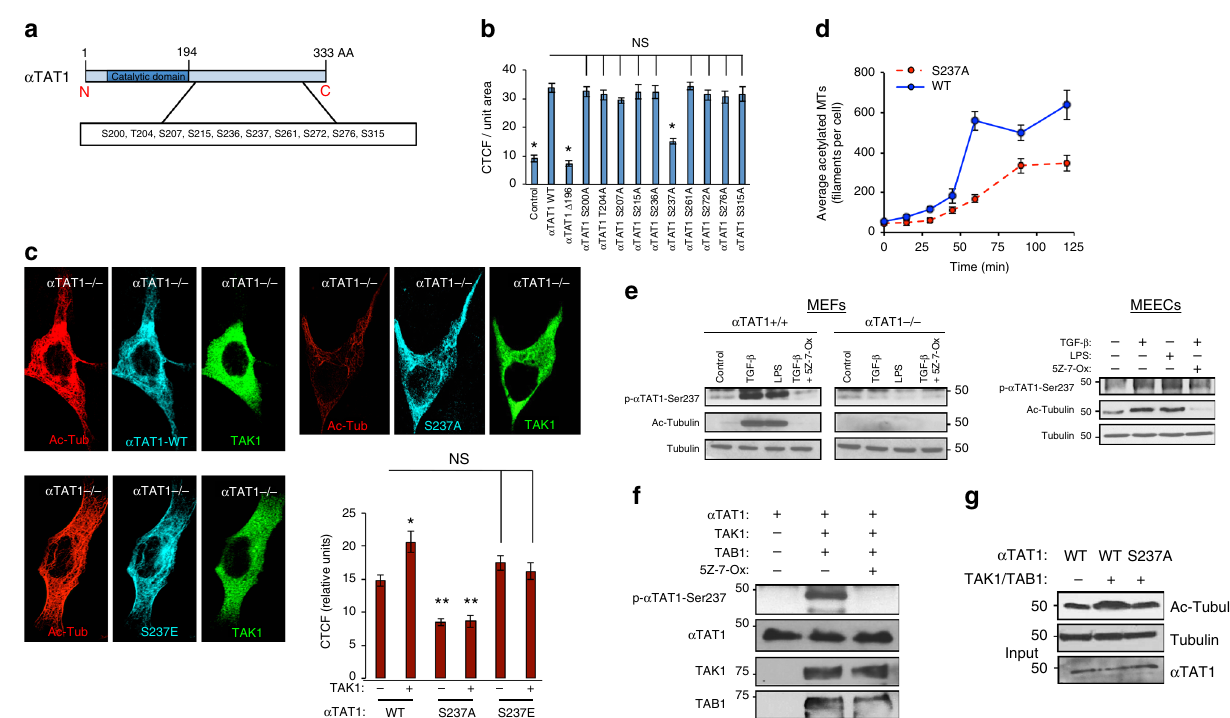
Fig. 4 α TAT1 catalytic activation requires direct phosphorylation at Ser237 by TAK1. a Schematic representation of α TAT1 serine/threonine to alanine single point mutants. b COS-7 cells expressing α TAT1 WT or the serine/threonine to alanine single point mutants were fi xed and imaged for α HA and Acetyl-tubulin. CTCF was quanti fi ed using Image J, at least 25 cells were quanti fi ed per condition. The images are representative of three independent experiments, n = 3. Error bars represent SEM and type 2 t -test analysis show relative to α TAT1 WT: * p < 0.001. c α TAT1 – / – MEFs expressing TAK1 WT or HA- α TAT1 WT, HA- α TAT1-S237A, and HA- α TAT1-S237E were fi xed and imaged for Acetyl-tubulin (red), α HA (pseudo color cyan), and TAK1 (green) immuno fl uorescence co-staining. CTCF per unit area was quanti fi ed using Image J, at least 30 cells were quanti fi ed per condition. Error bars represent SEM and type 2 t -test analysis show relative to α TAT1 WT: * p < 0.001; ** p < 0.0001. d COS-7cells expressing HA- α TAT1 WT or HA- α TAT1-S237A were subjected to nocodazole (100 nM) for 1 h, washed thoroughly with PBS, and then immediately fi xed after 0, 15, 30, 45, 60, 90, and 120 min. The fi xed cells were then imaged for α HA and Acetyl tubulin immuno fl uorescence co-staining. The images were quanti fi ed by skeletonizing the acetyl tubulin staining using Image J and skeletons analyzed for length and branching of acetyl tubulin fi laments. e α TAT1 + / + MEFs, α TAT1 – / – MEFs, and mouse embryonic endothelial cells were treated with TGF- β (200 pM), LPS (10 ng/ml) for 30 min, or pre-treated with 5Z-7-oxozeaenol (20 μ M) for 15 min followed by TGF- β stimulation. f In vitro kinase assay performed using puri fi ed α TAT1, TAK1, and TAB1 were incubated with and without treatment with 5Z-7-oxozeaenol (20 μ M). g In vitro acetylation assay performed using puri fi ed tubulin, α TAT1, α TAT1-S237A, TAK1, and